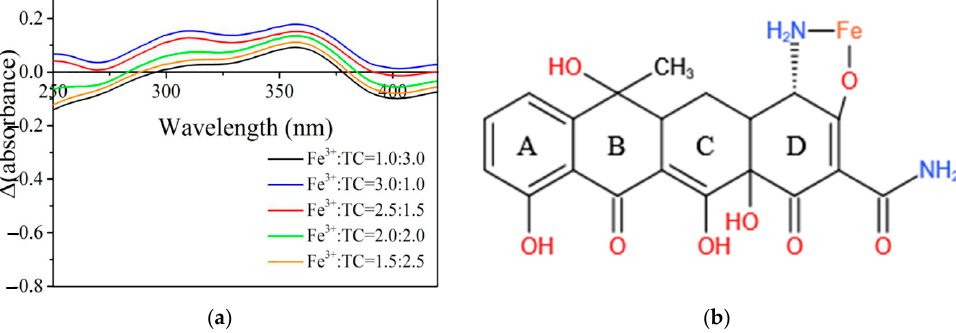
Figure 6. Δ Abs variation and possible molecular formula of its compound with Fe 3+ and TC at different concentration ratios. ( a ) Δ Abs variation curve. ( b ) Molecular structure of TC-Fe compound.